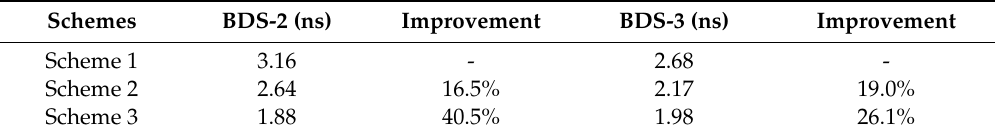
Figure 6. Residuals of each epoch on DOY 60 across the three schemes tested.